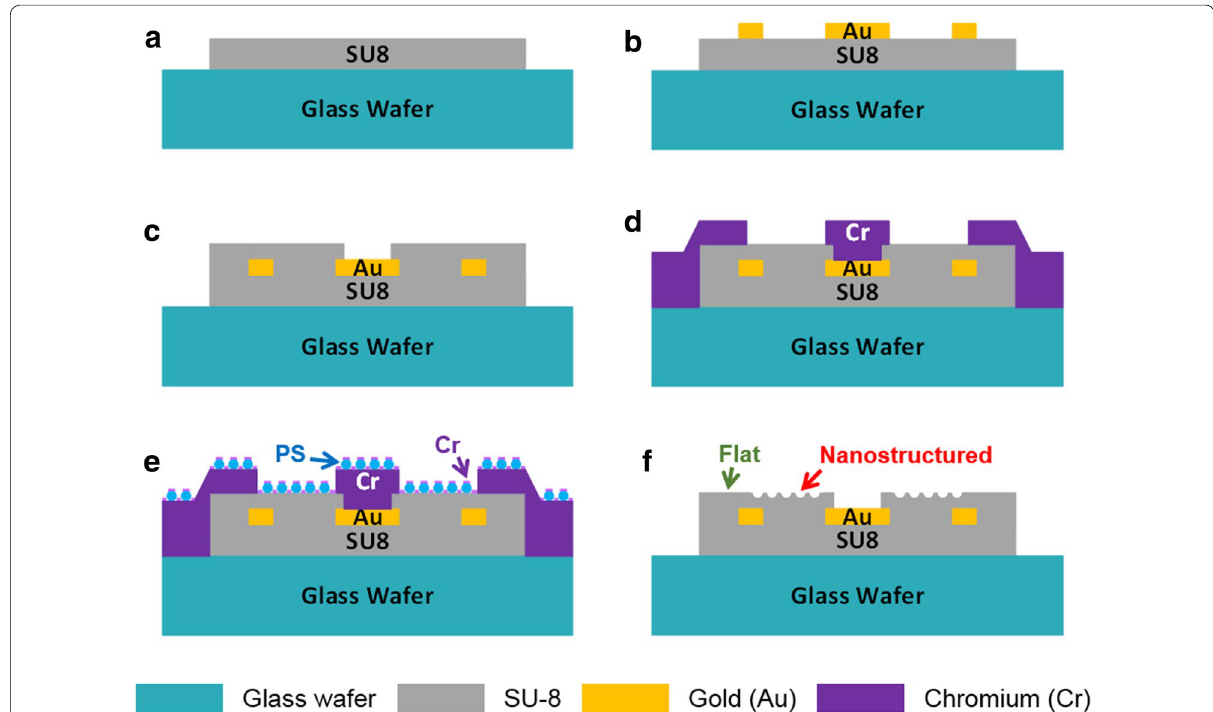
Fig. 2 Fabrication of nanostructures on the microprobe surface: a negative photoresist coating on a glass wafer; b Ti and Au deposition using a Cr mask and inductively coupled plasma reactive‑ion etching (ICP‑RIE) of an Au layer as an electrode; c coating with an SU‑8 passivation layer; d depo‑ sition of a Cr layer on the SU‑8 microprobe; e self‑assembly of polystyrene beads (~ 300 nm diameter) and reduction of polystyrene bead diameter using RIE followed by deposition of a 30 nm Cr layer; and f removal of polystyrene beads by sonication in toluene for 1 h, nanoscale etching of the SU‑8 surface, and removal of the Cr mask using a Cr